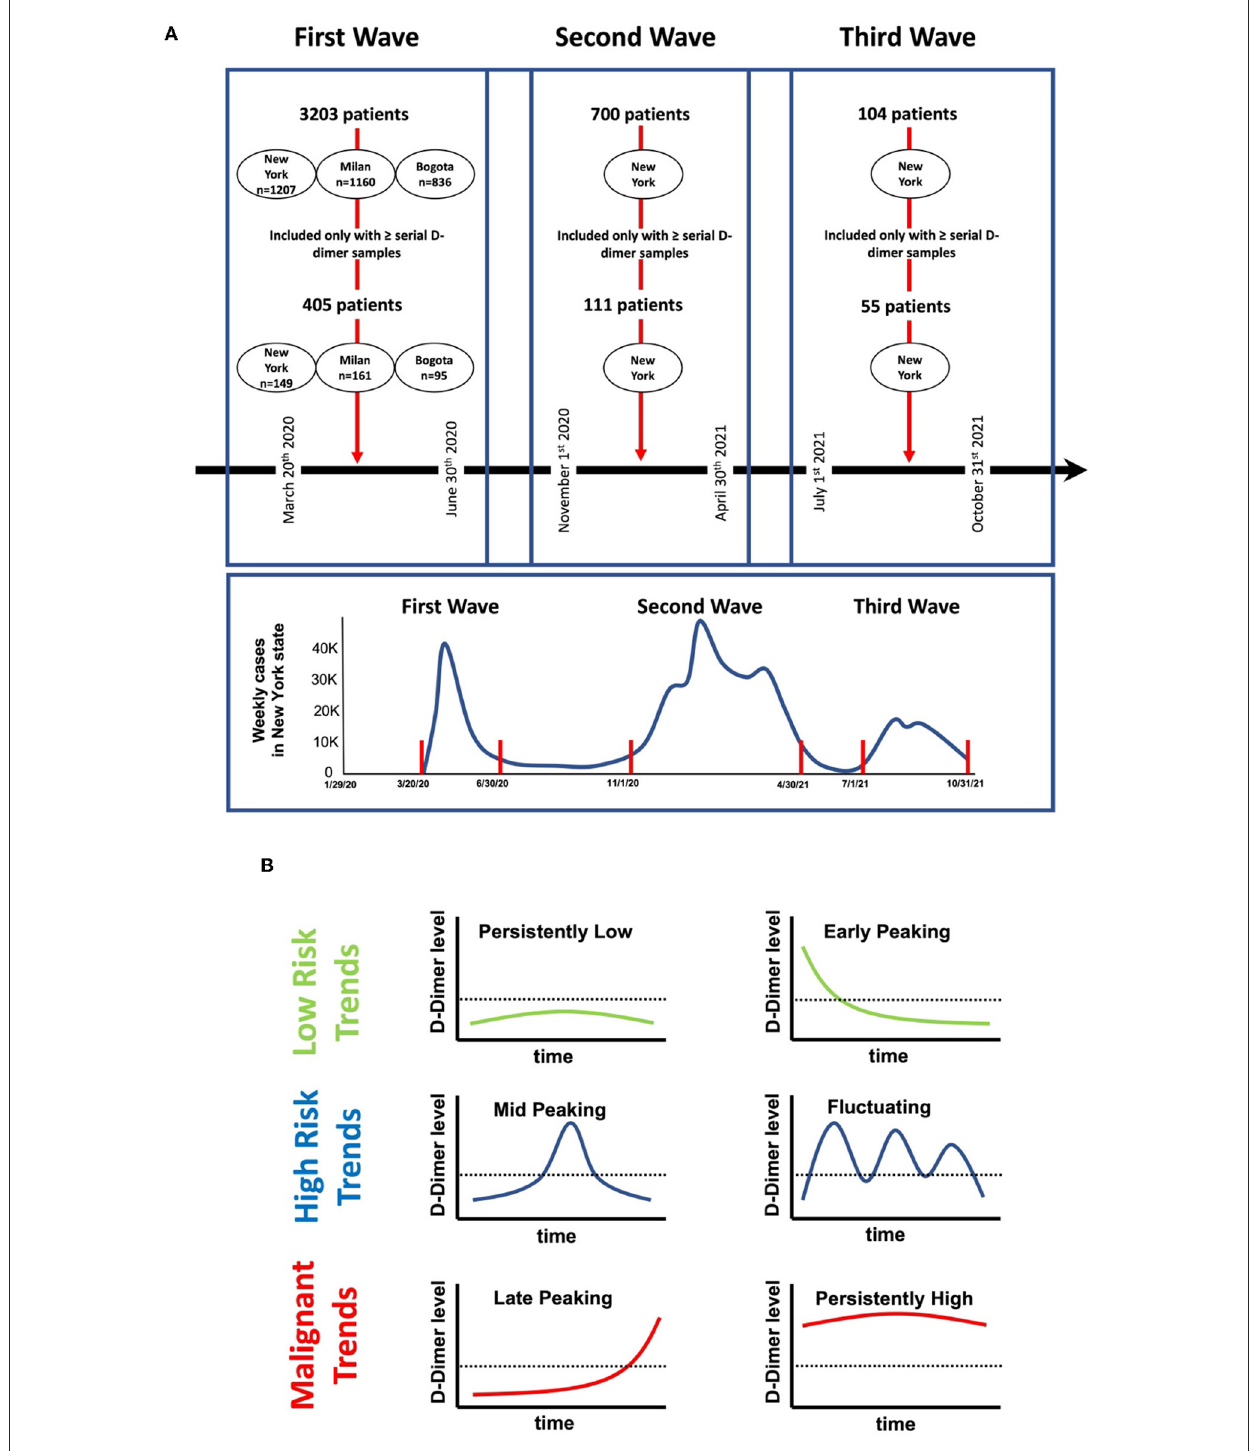
FIGURE1 Study timelines and protocol. (A) Number of patients involved in the study at each center according to the defined time points in the first, second, and third waves. (B) Schematic representation of in-hospital D-dimer patterns observed in our study. Persistently-low: if D-dimer levels during admission were below 1,000ng/ml and stayed below 1,000ng/ml throughout the hospitalization. Early-peaking: D-dimer levels on admissions were > 1,000ng/ml and immediately normalized to levels < 1,000ng/ml and stayed low for the rest of the hospitalization. Mid-peaking: D-dimer levels were < 1,000ng/ml on admission, however, peaked at levels > 1,000ng/ml during the hospitalization, and then immediately decreased and stayed low for the rest of the hospitalization. Fluctuating: D-dimer levels were either low or normal during admission, however, with multiple rises and falls > 1,000ng/ml during the hospital course. Late-peaking: D-dimer levels were < 1,000ng/ml on admission and stayed low throughout the hospitalization, however, exhibited a sudden rise to levels > 1,000ng/ml at the end of the encounter. Persistently-high: D-dimer levels were > 1000ng/ml on admission which stayed high throughout the